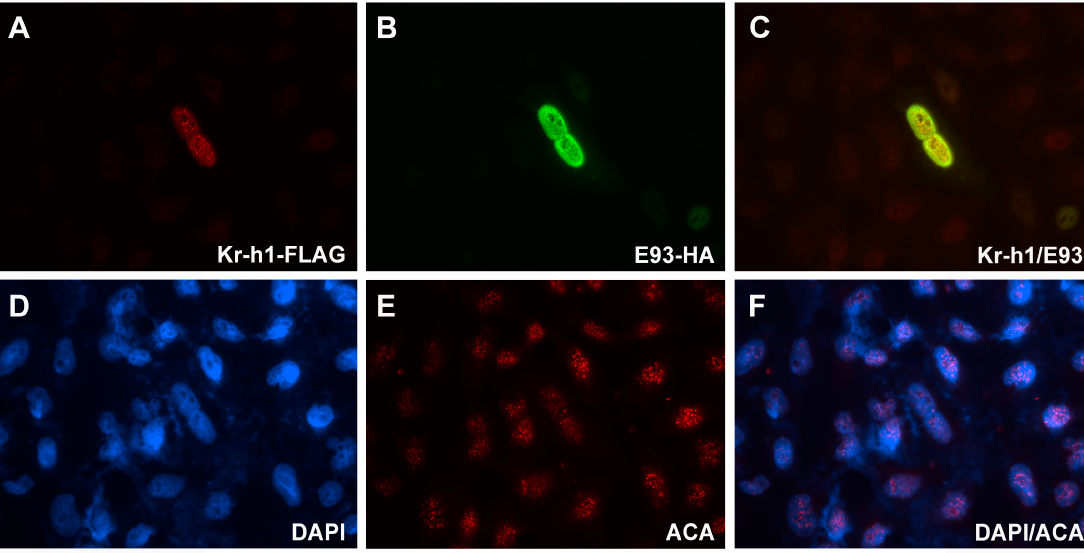
Figure 4. Co-localization of E93 and Kr-h1 in the nucleus (600 × magnification). DAPI was used to stain the nucleus. Anti-HA and anti-FLAG were used to show the sub-cellular localization of E93 and Kr-h1, both of which were fused to tags separately. ACA was used to stain the centromere as an internal control. ( A ) FLAG-tagged Kr-h1; ( B ) HA-tagged E93; ( C ) Merge of FLAG-tagged Kr-h1 and HA-tagged E93; ( D ) DAPI; ( E ) ACA; ( F ) Merge of DAPI and ACA.